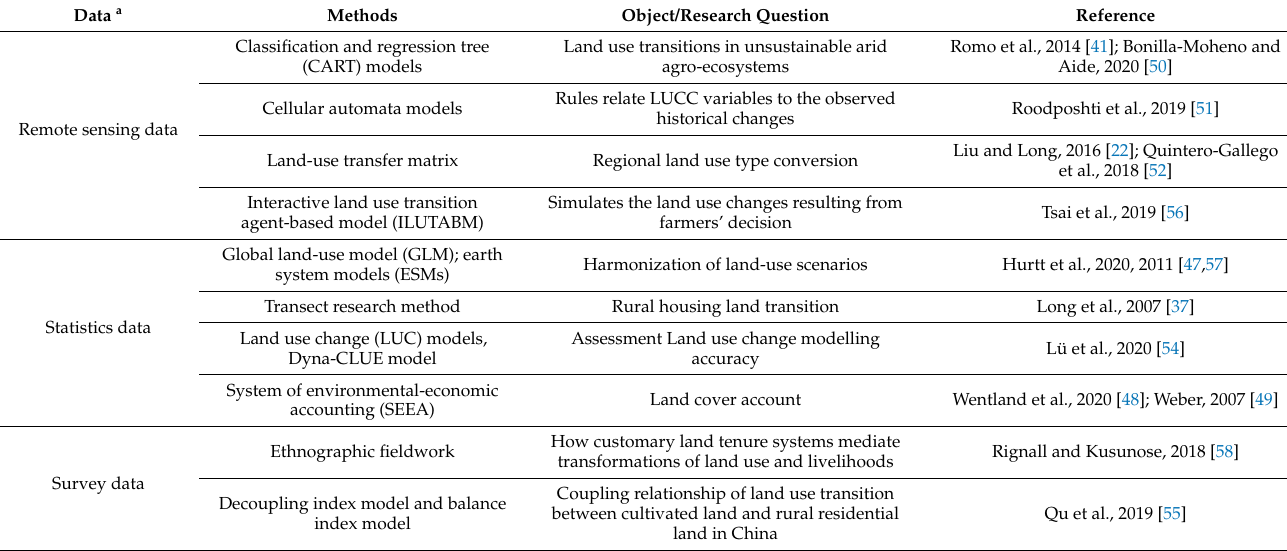
Table 3. Characterization and measurement methods of